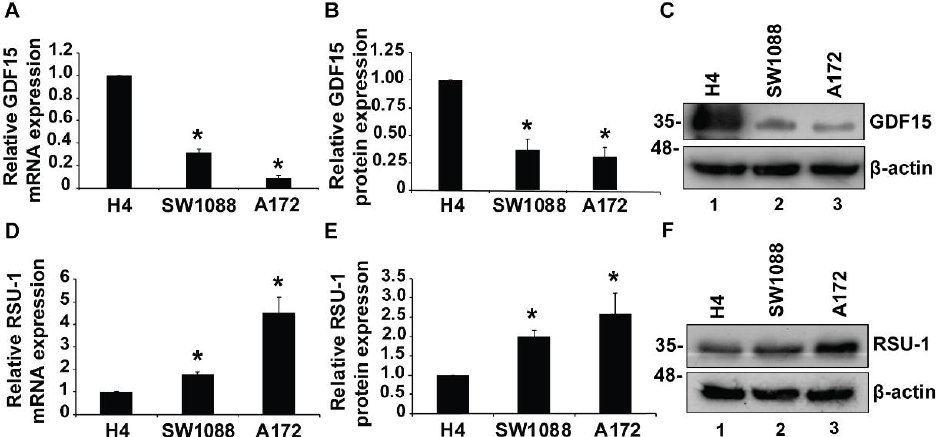
Figure 1. Growth differentiation factor ( GDF15 ) expression decreases from the less aggressive (H4) towards the more aggressive (A172) cells, whereas the RSU-1 expression follows the opposite pattern. ( A – D ) Relative GDF15 and RSU-1 mRNA expression in three brain cell lines (H4, SW1088 and A172). Three independent real-time polymerase chain reaction (PCR) experiments were performed. ( B – E ) Western blot for GDF15 and RSU-1 protein expression with H4 cell line as the sample control and β-actin as the loading control. ( C – F ) Graphs show the quantification of GDF15 and RSU-1 protein expression with ImageJ software from two different Western blots. Asterisks denote a statistically significant difference ( p < 0.05) compared to the H4 data.